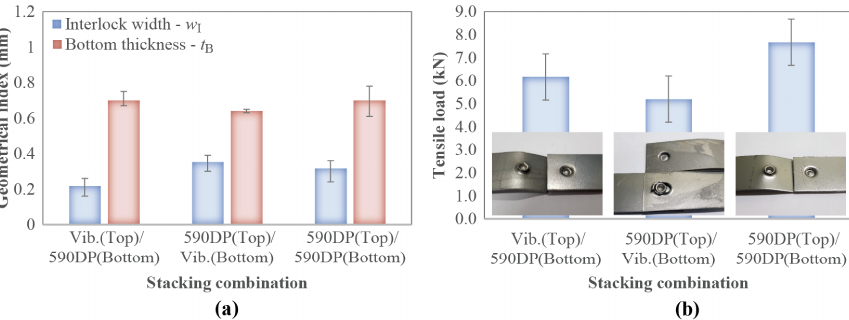
Figure 9. ( a ) w I and the t B and ( b ) the tensile shear loads for self-piercing riveted joint between vi- bration-damping steel and steel alloy under di ff erent panel stacking combinations.